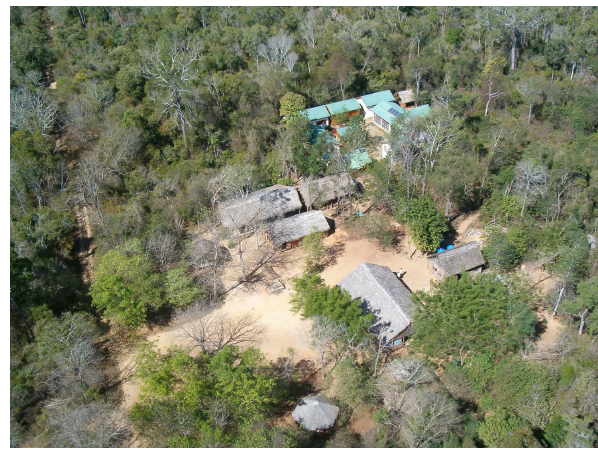
Figure 2. Aerial view of the Kirindy field station. Operated by DPZ since 1993, it is now the largest DPZ field station (Photo: Deutsches Primatenzentrum